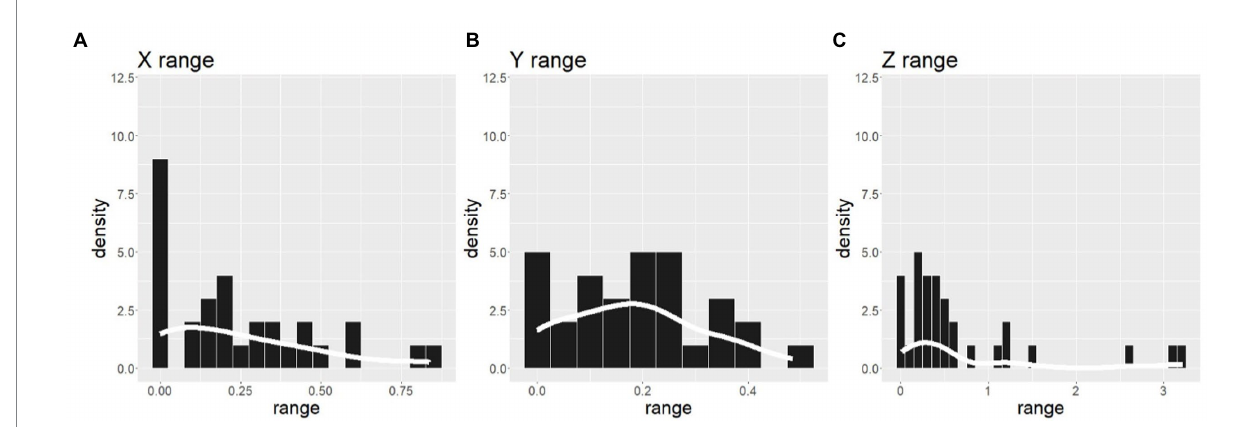
FIGURE 6 Frequencies of the positional ranges to draw spheres for X (A) , Y (B) , and Z (C) axes. The range values were different among a-c because of the OpenGL coordinate system.